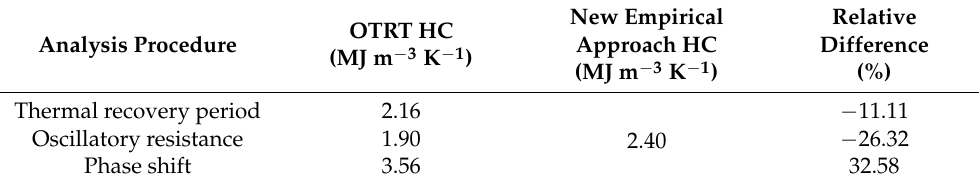
Table 4. Subsurface HC inferred with the new empirical method compared to the results obtained by [11] using the OTRT method at the INRS experimental